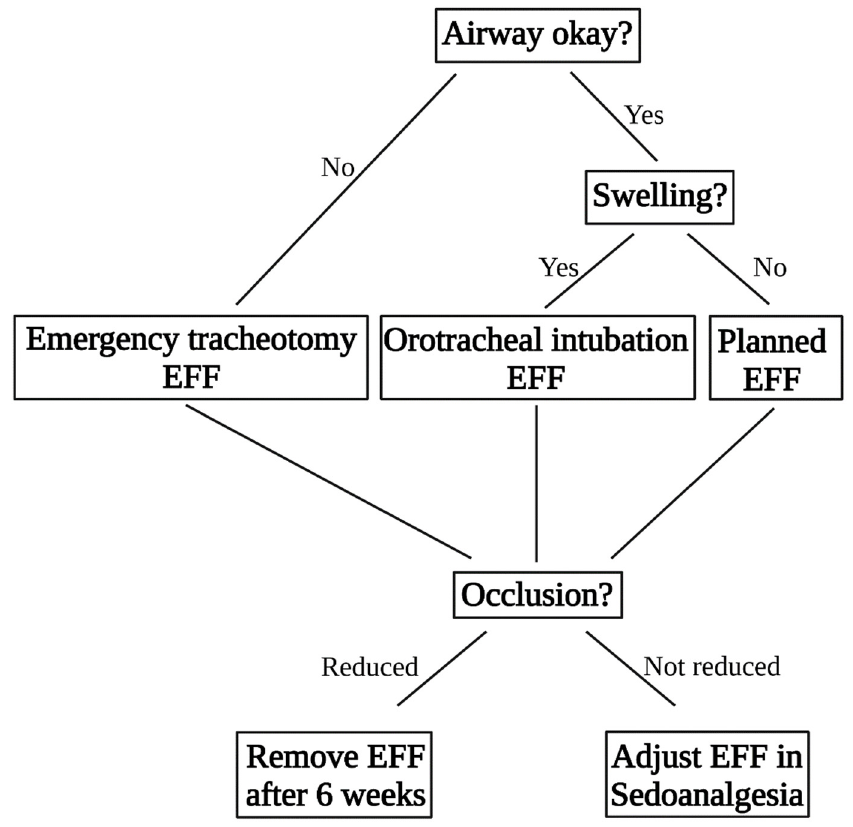
Figure 2. Flowchart and decision-making of the patient guidance from the first contact to the operation to healing.